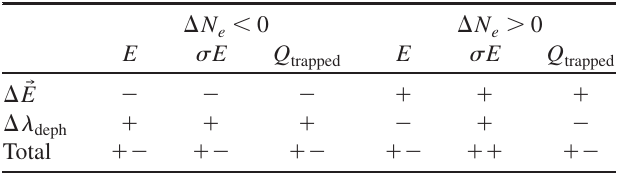
EFFECTS OF TIMING AND STABILITY ON LASER . . TABLE IV. Expected effect of the variations in plasma density due to both the changing plasma wave field strength ( (cid:1) ~E ) and the changed dephasing length ( (cid:1) (cid:7) deph ) on the energy ( E ), energy spread ( (cid:5)E ), and trapped charge ( Q trapped ).